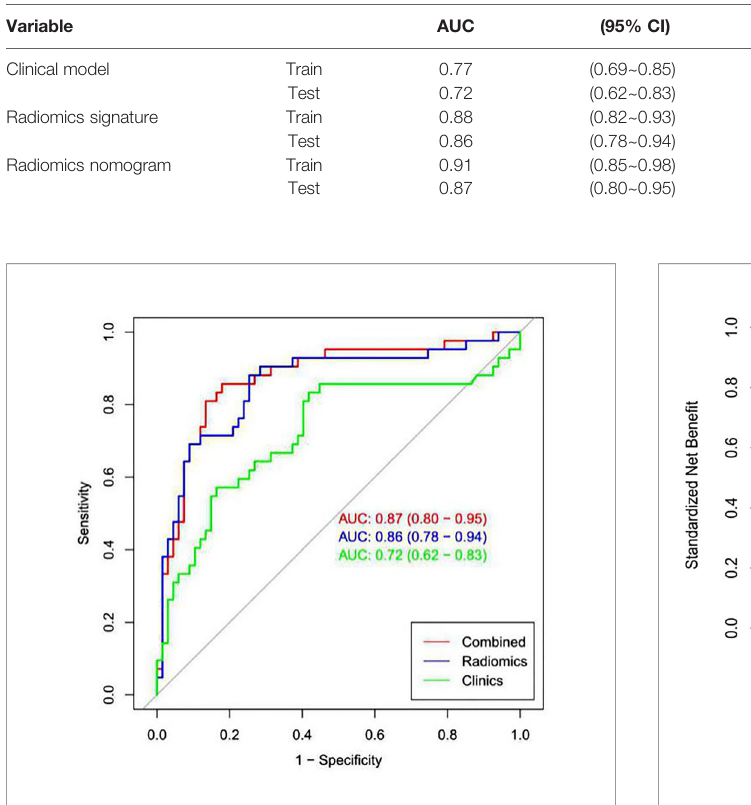
FIGURE 8 | ROC analysis was used to compare the prediction ef fi ciency among the nomogram, radiomics signature and clinical models. The red line shows the nomogram with AUC=0.87, indicating that the radiomics nomogram had better predictive performance than the clinical model (green line; AUC=0.72) or radiomics signature (blue line; AUC=